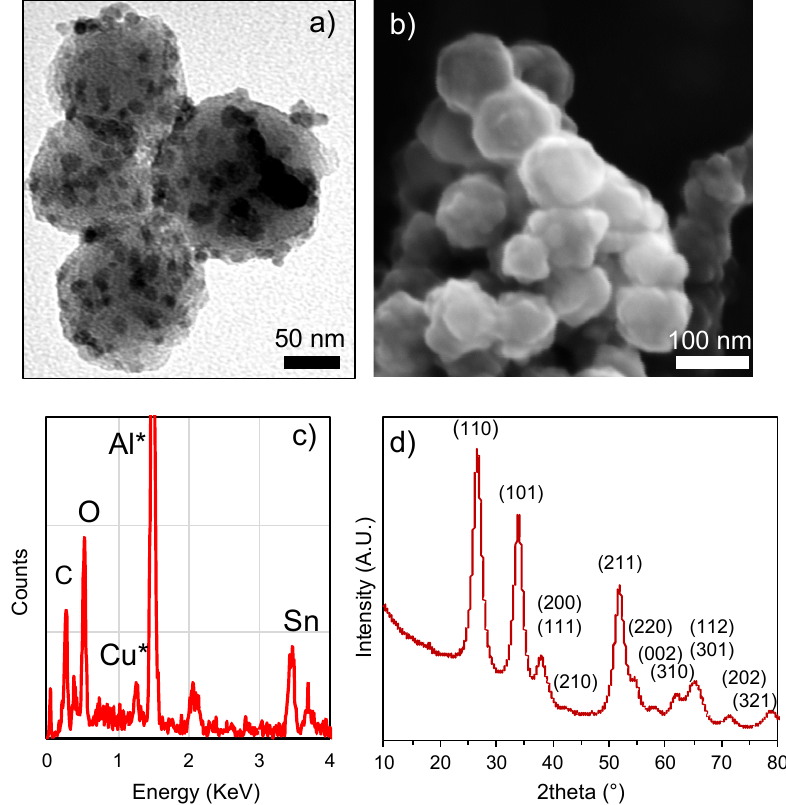
Figure 5. TEM ( a ) and SEM ( b ) images showing SnO 2 @C nano-rattle after melt diffusion; EDS spot analysis confirming the presence of Sn, O and C elements ( c ). XRD of after molten Sn precursor melt di ff usion impregnation ( d